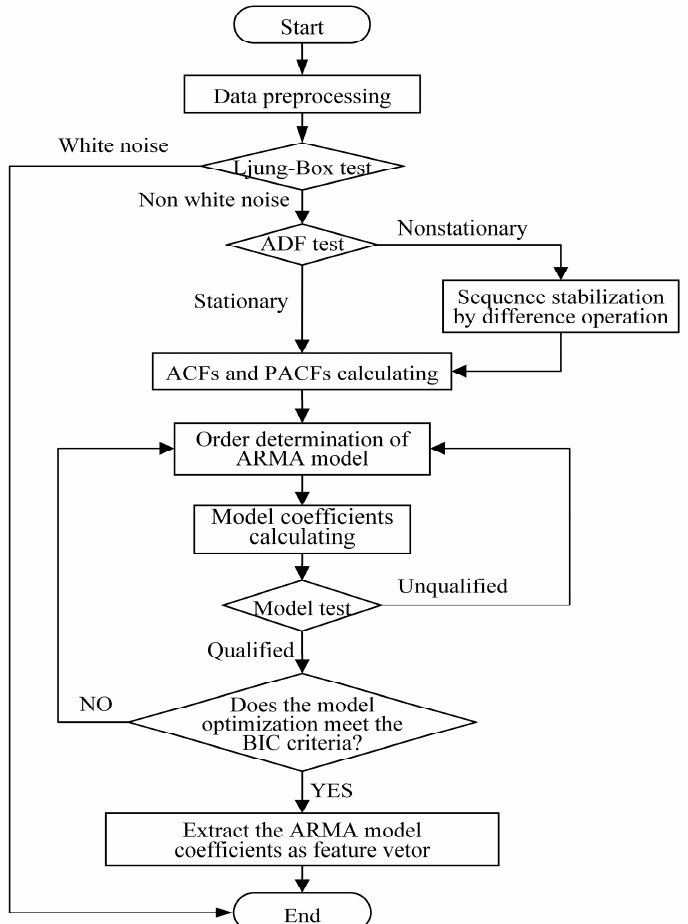
Figure 3. Flow chart of feature extraction of PD patterns.